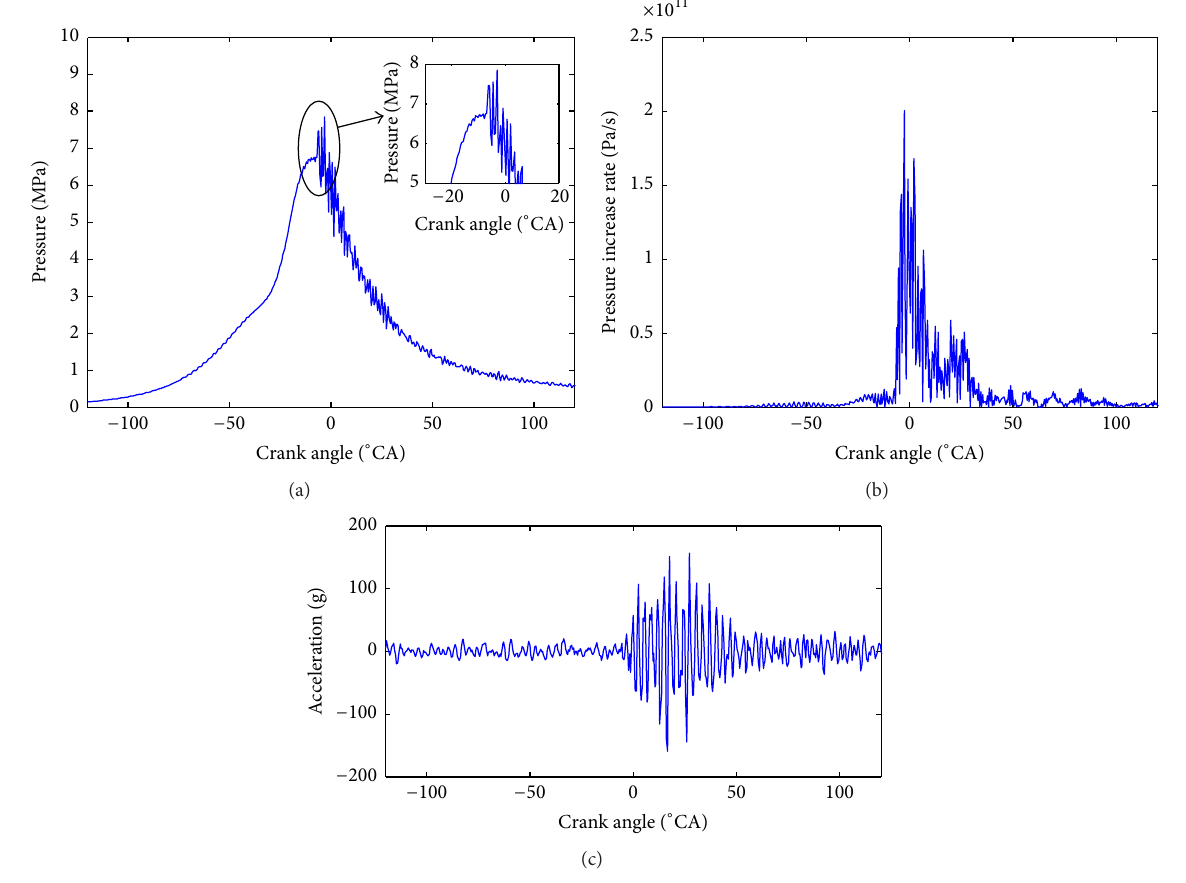
Figure 7: (a) Cylinder pressure signal of typical knock condition. (b) Cylinder pressure increased rate signal of typical knock condition. (c) Cylinder block vibration signal of typical knock